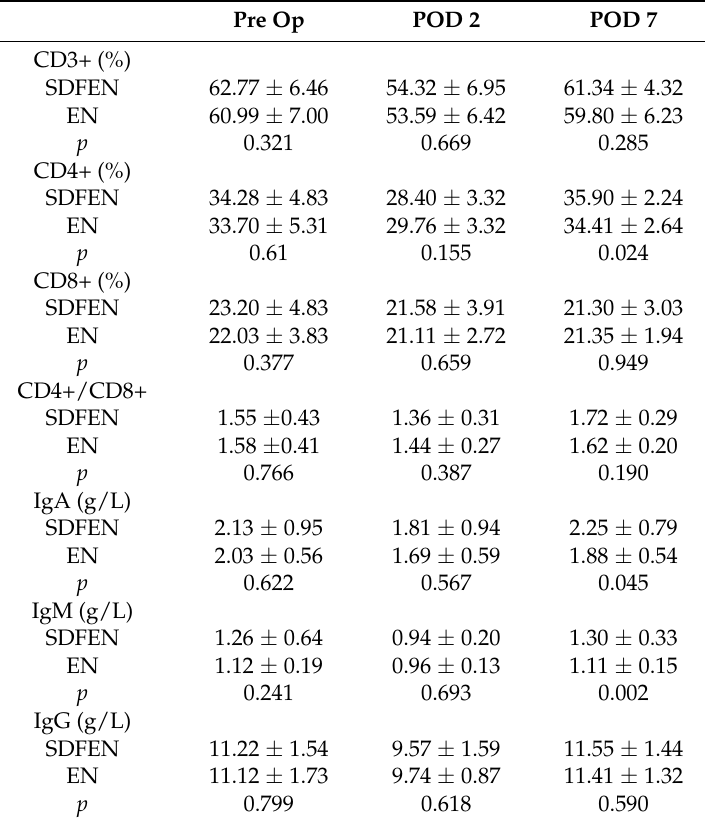
Table 4. Comparison of the two groups’ immune index.